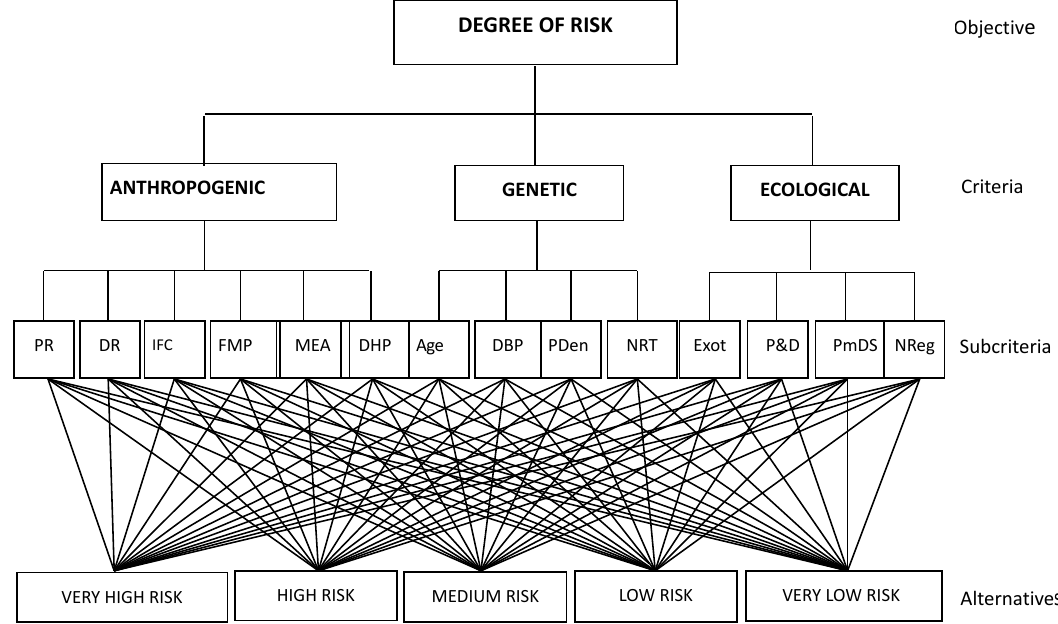
Figure 2. Decision problem hierarchization and sub-criteria considered. PR: Property